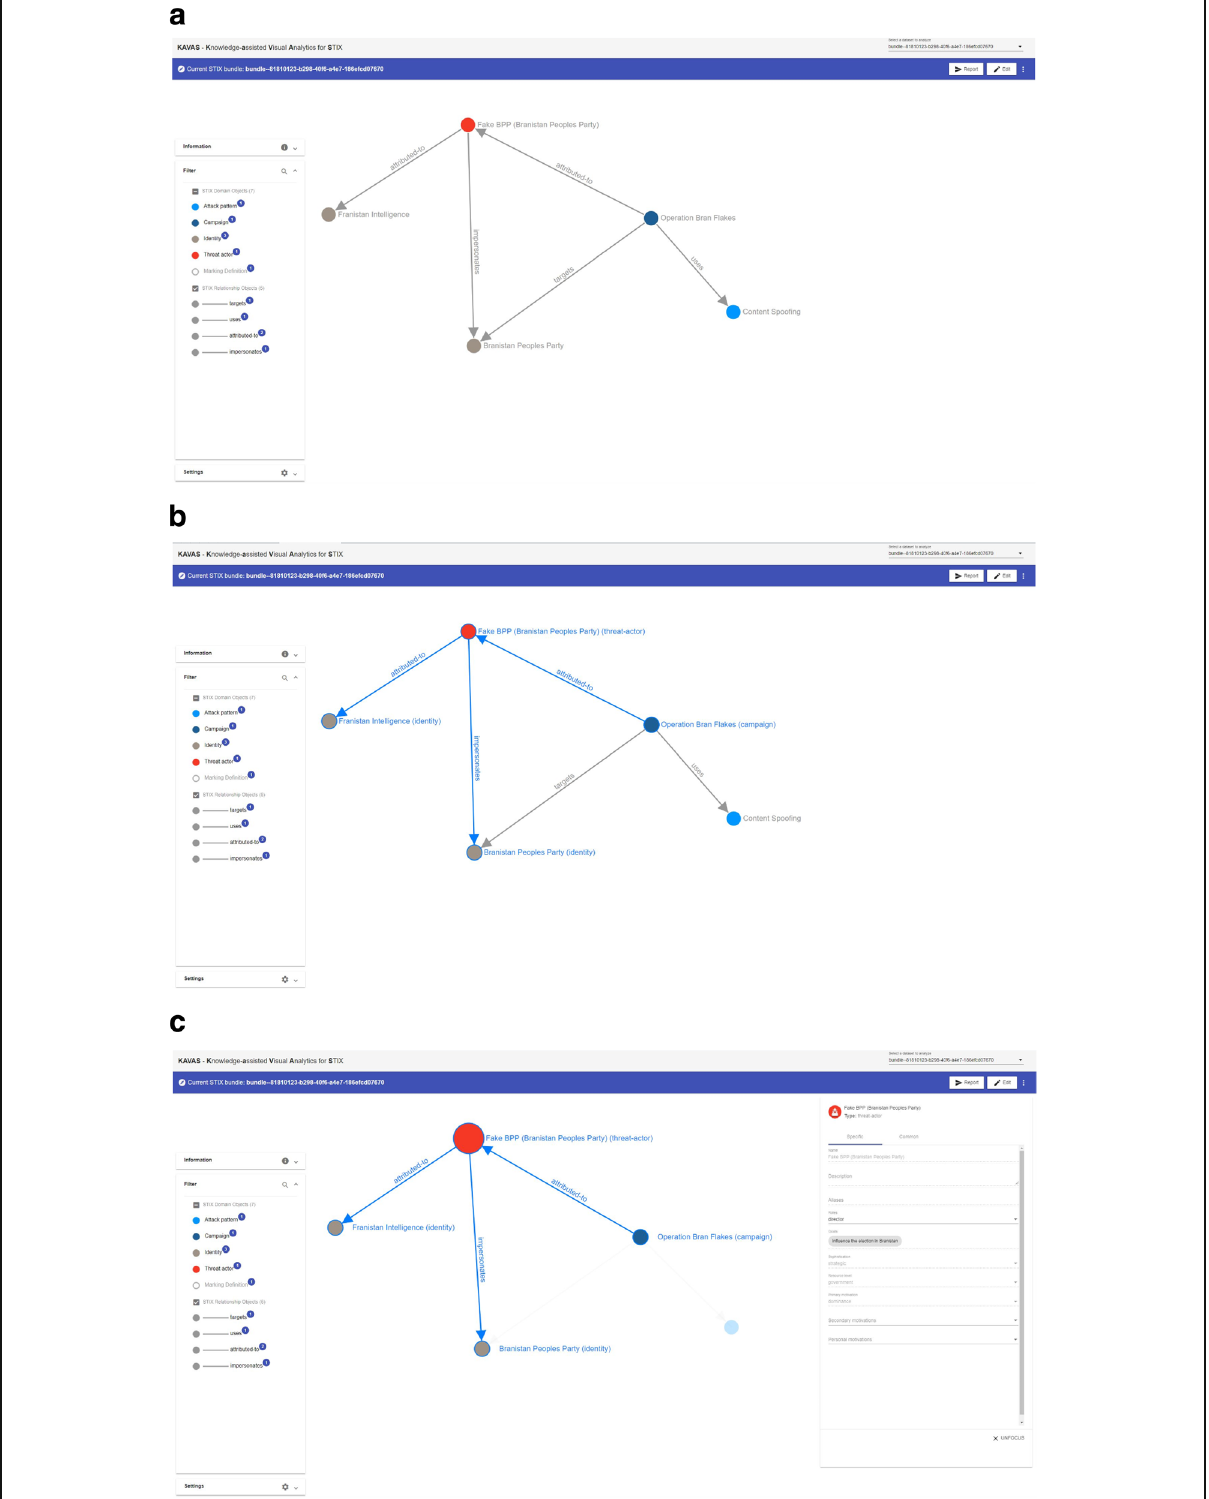
Fig. 5 Phases of Information Seeking Mantra in KAVAS A prototype of KAVAS is available at http://bit.ly/2v9mSna. The displayed bundle ’ s id is bundle – 81,810,123-b298-40f6-a4e7-186efcd07670 and it can be accessed via the drop-down menu in the toolbar of KAVAS. a Overview ( b ) Zoom and Filter ( c ) Details on